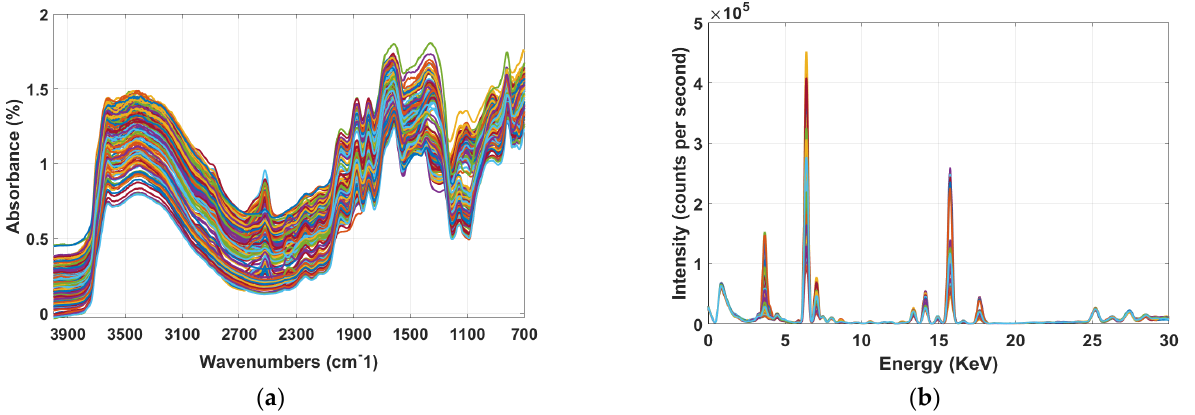
Figure 3. The mid-infrared (MIR) ( a ) and X-ray florescence (XRF) spectra ( b ) of samples used during the